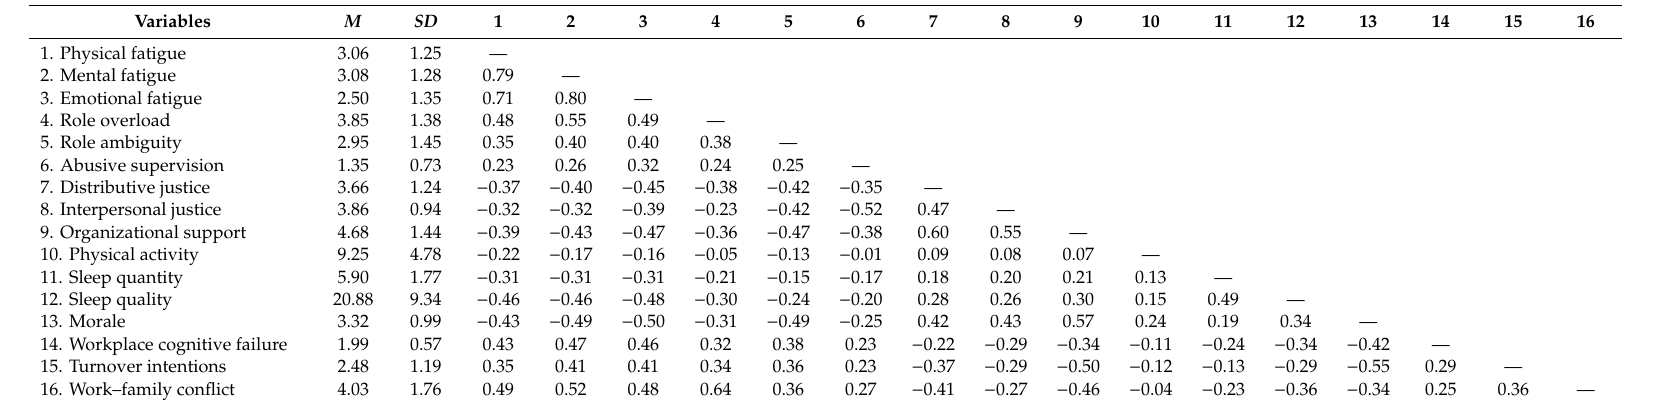
Table 1. Weighted Descriptive Statistics and Zero-Order Correlations for Study Variables.